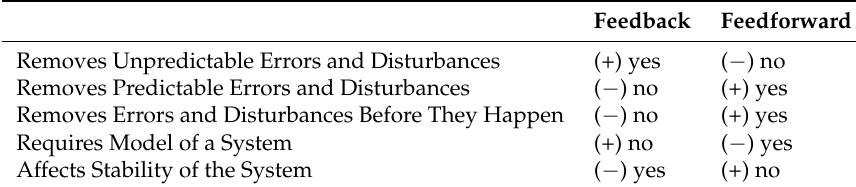
Table 1. Feedforward vs Feedback